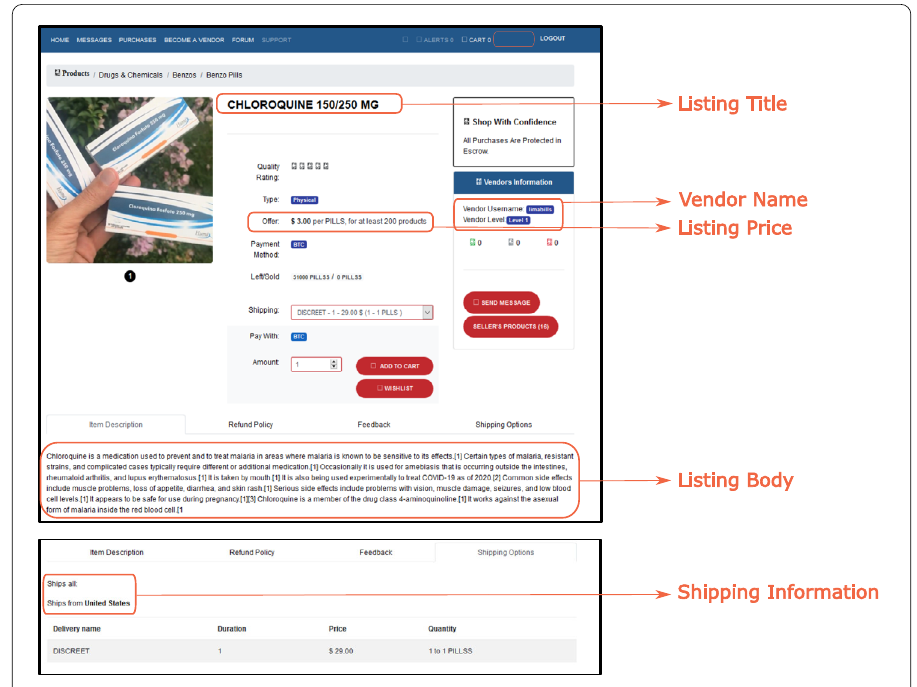
Figure 1 Example of a chloroquine listing in the DarkBay/Dbay marketplace, where we highlight some of its salient attributes. Among the attributes considered in this work and shown in Table 4, “Time” and “Marketplace name” attributes are not present in this screenshot, while the “Quantity” attribute is not fixed by the vendor